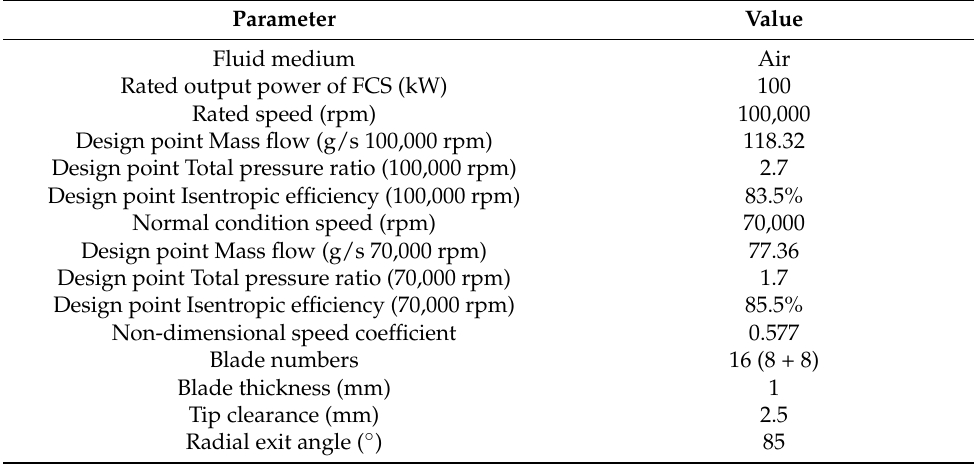
Figure 5. CAD of the original impeller. Table 3. Aerodynamic and geometric parameters of the centrifugal compressor.